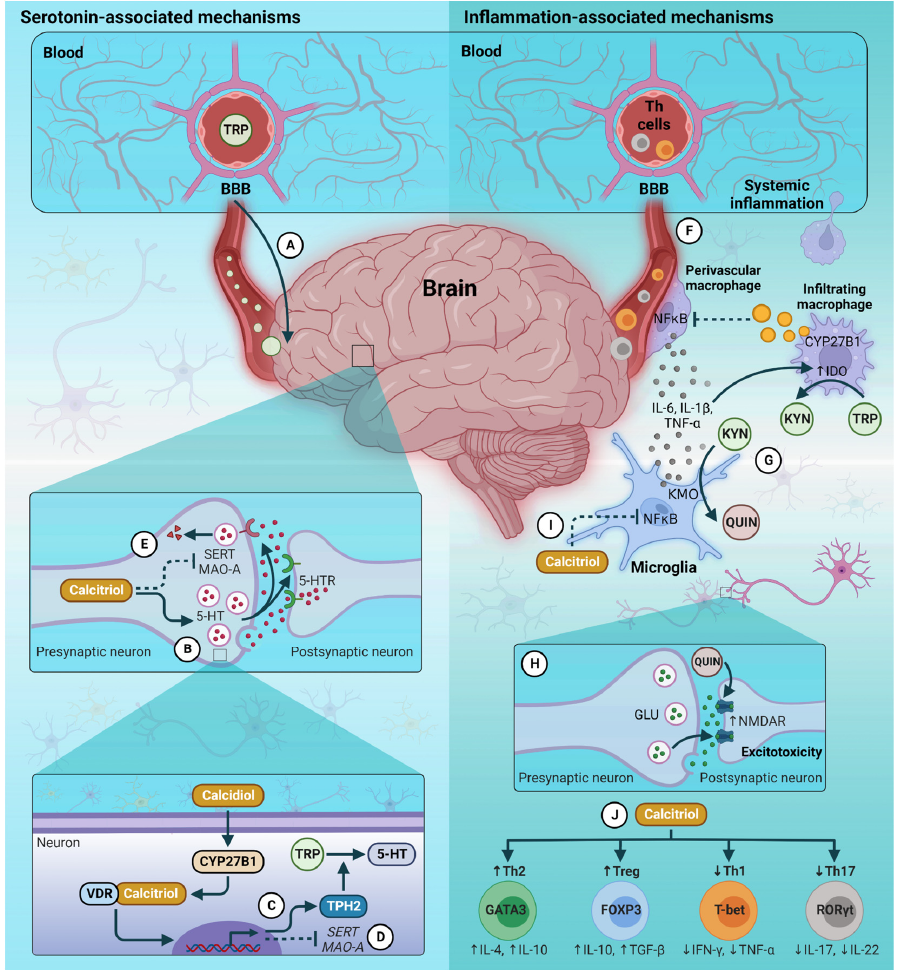
Figure 2. Protective mechanisms of vitamin D against depression. ( A ) TRP is an essential amino acid obtained from the diet. Dietary TRP that is not metabolized (e.g., in the intestine or